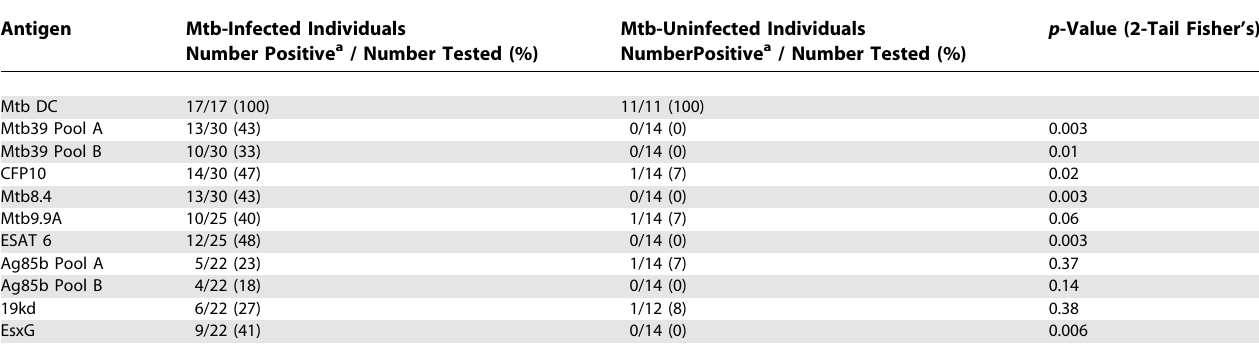
Table 1. CD8 þ T Cell Responses to Known TB Antigens Antigen Mtb-Infected Individuals Number Positive a / Number Tested (%)